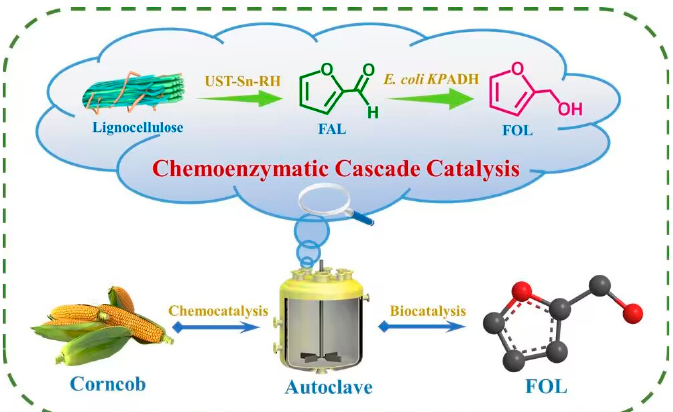
Figure 1. A chemoenzymatic cascade strategy for synthesis of furfuryl alcohol (FOL) from corncob (CCB).